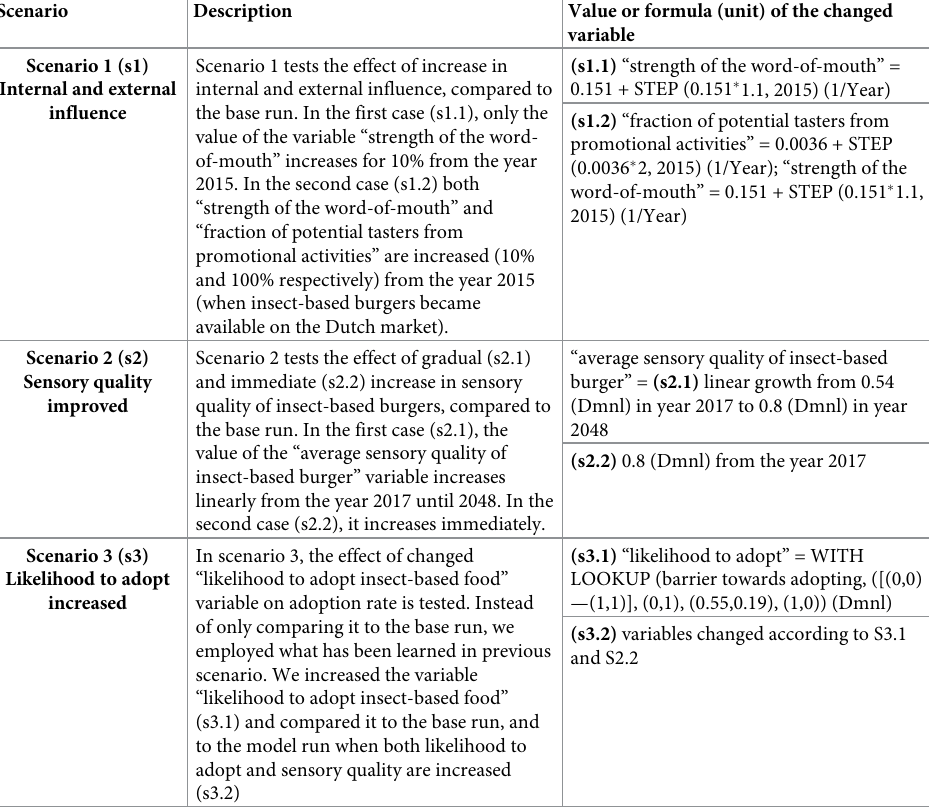
Table 3. Description of the three different scenarios as simulation